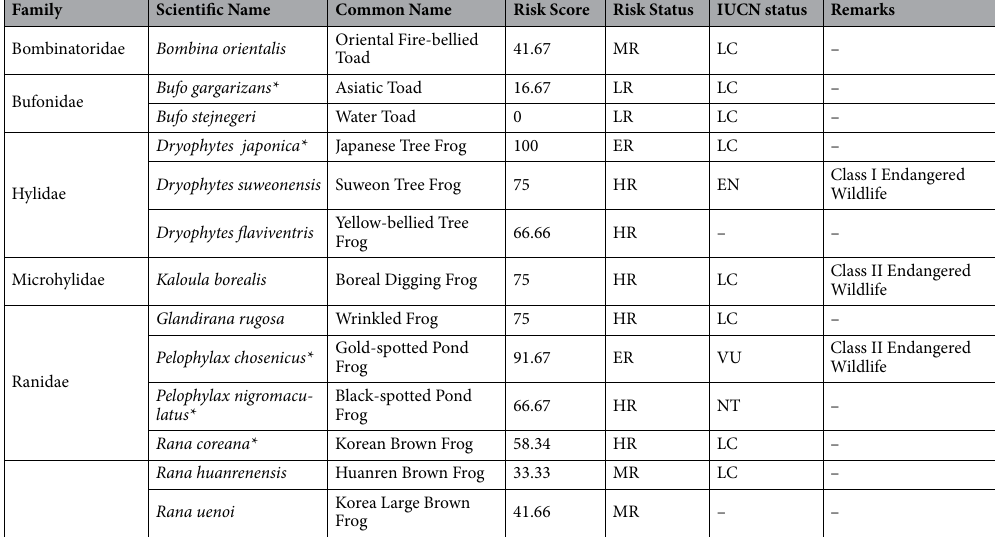
Table 4. Risk statuses of the anurans of South Korea from the invasion of L. catesbeianus . ‘*’ marked species were found in the study areas coinhabiting the